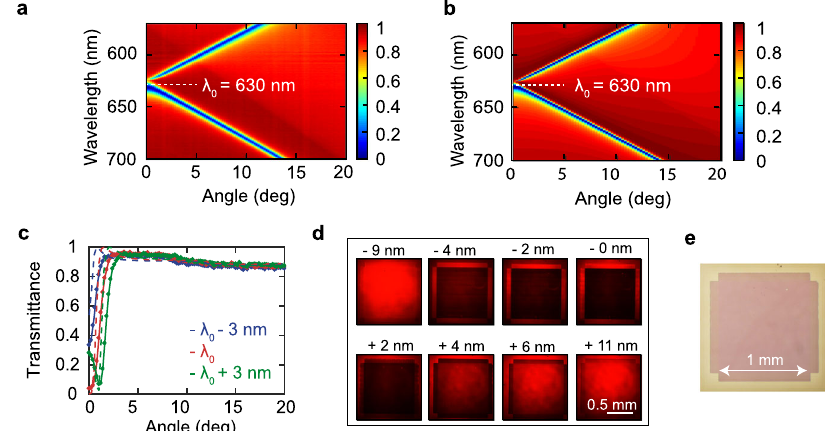
Fig. 3 | Experimental validation of the angular response of our NLM. a Experimental map of the metasurface transmittance versus wavelength and incidentanglethatre fl ectsthedispersionofthetransversemagnetic(TM)modeof thesingle-modesiliconnitrideslabcorrugatedwiththegrating. b Simulatedmapof the transmittance that closely matches the experiments in panel a . c Angle- dependent transmittance of the NLM at three wavelengths near the resonant